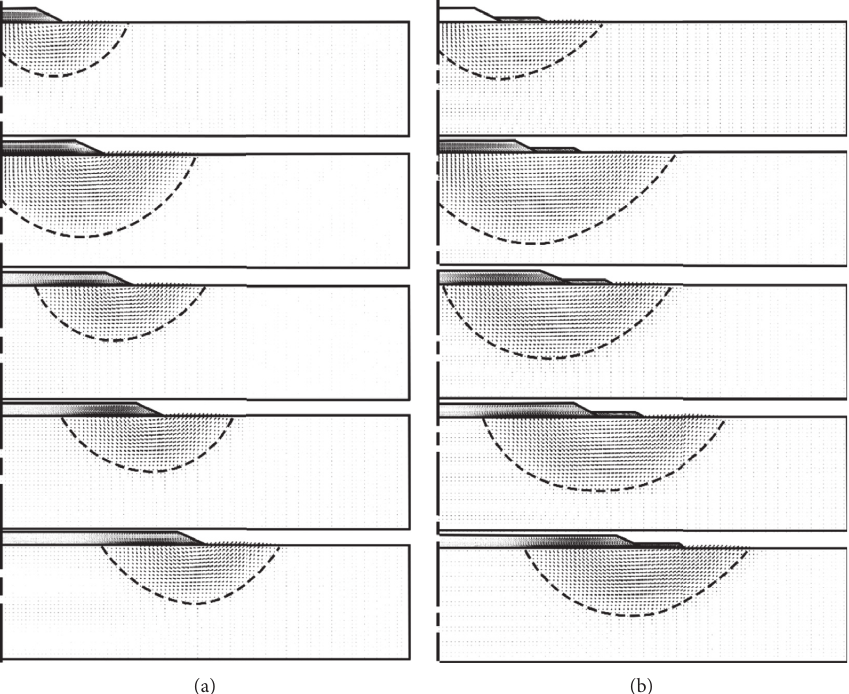
Figure 7: Soil heaving mechanism of large-scale sandbag cofferdams (a) without rockfill berms or (b) with rockfill